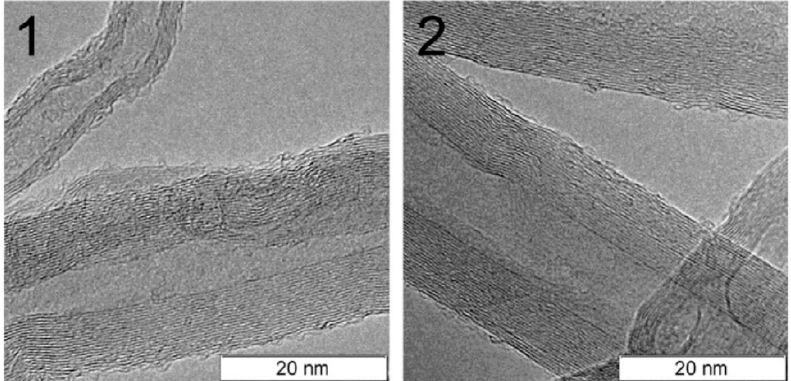
Figure 19. High-resolution transmission electron microscopy (HRTEM) images of CNT as prepared ( 1 ) and oxidized ( 2 ) [7].